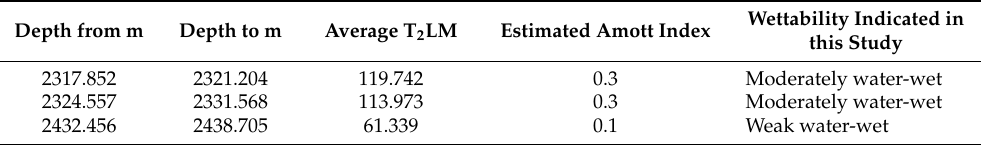
Figure 21. Plot of figures showing the SW against T 2 LM trends in different oil intervals. Table 8. Quantitative evaluation of wettability conditions.